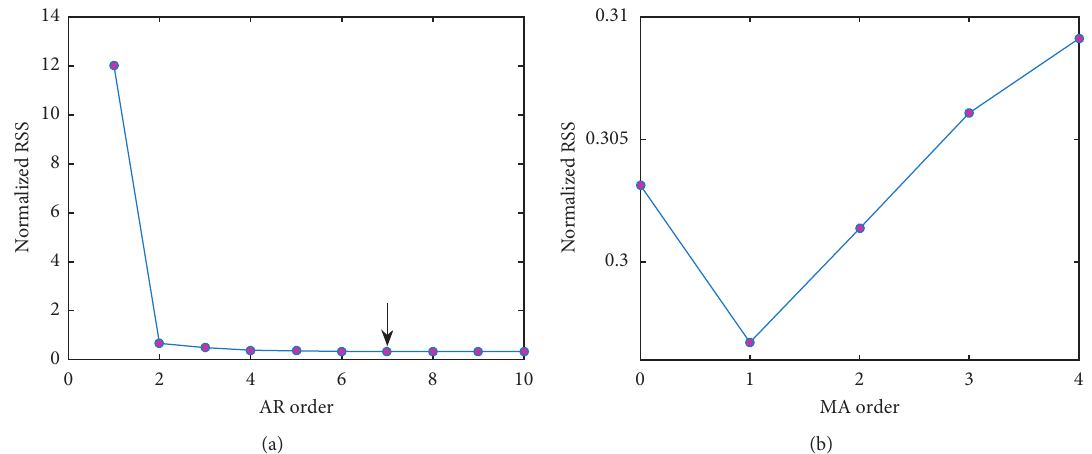
Figure 4: Model structure selection of the SWRMCRR-KTARMA method: (a) AR order and (b) MA